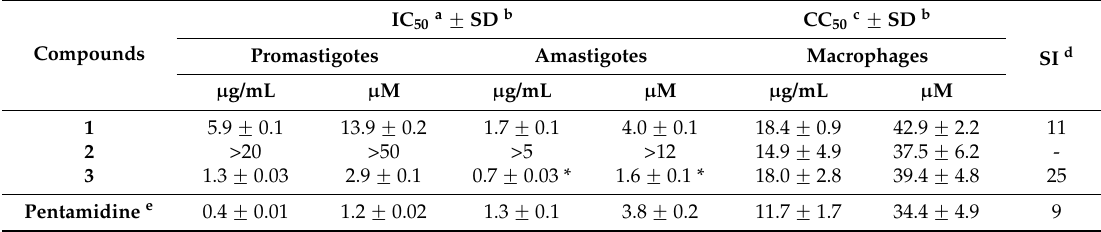
Table 1. Antileishmanial and cytotoxic activity of isolated compounds from Trametes versicolor .